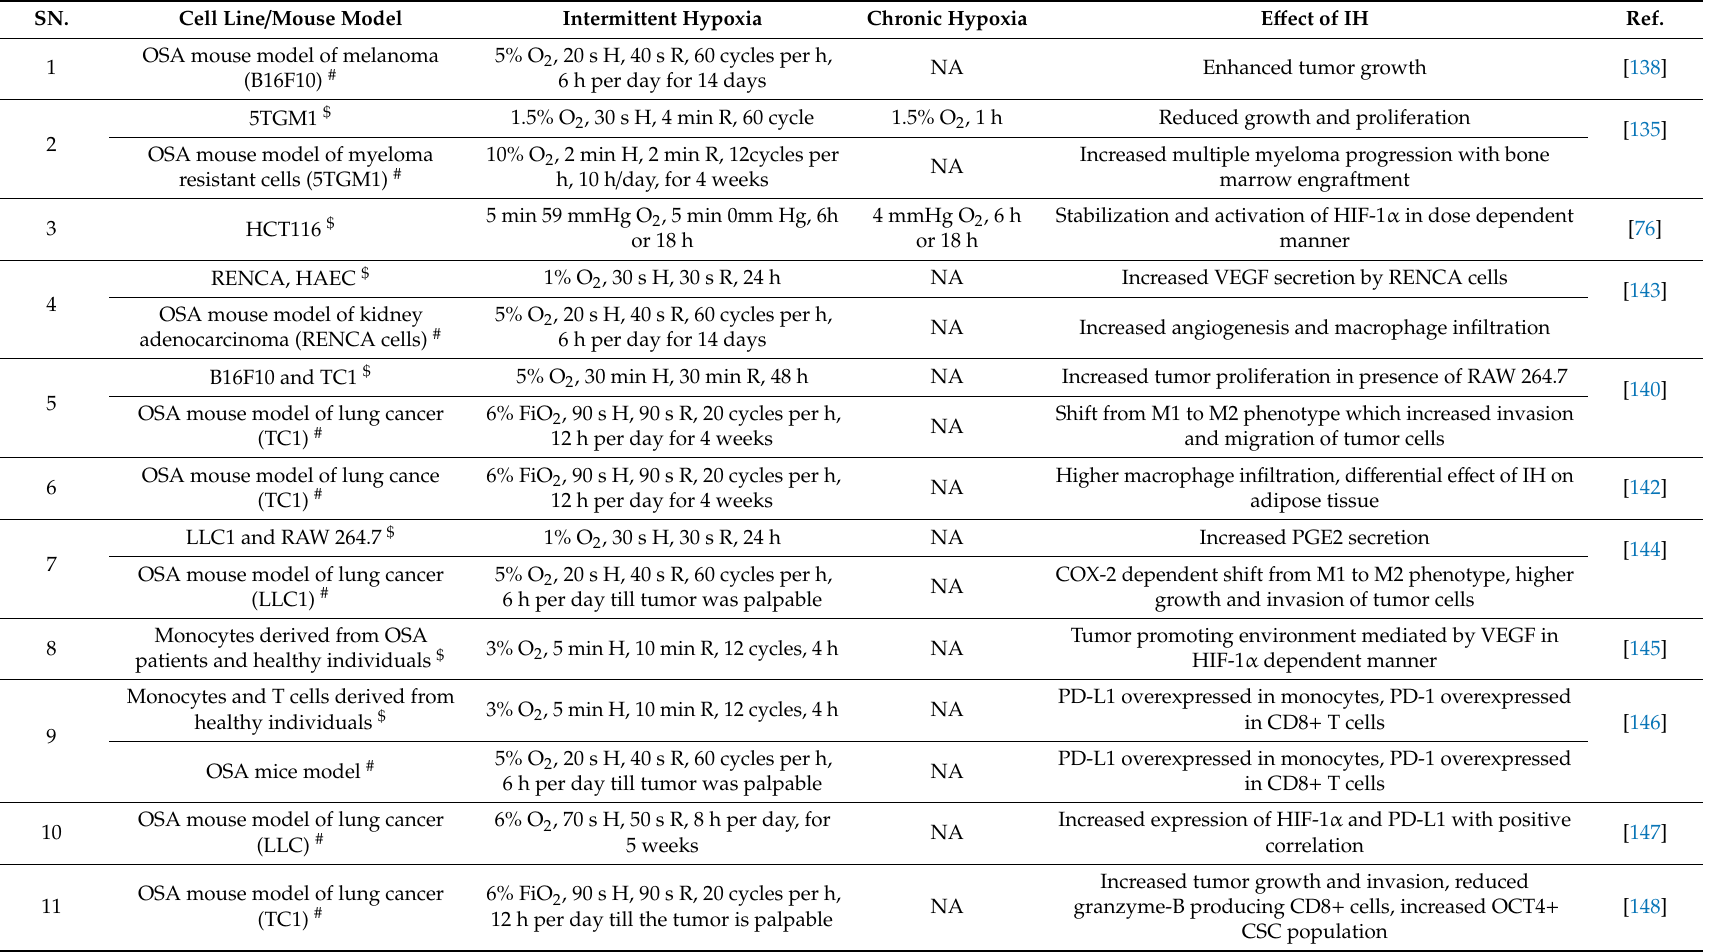
Table 7. Role of IH in aggressiveness of cancer from obstructive sleep apnea (OSA) model studies.